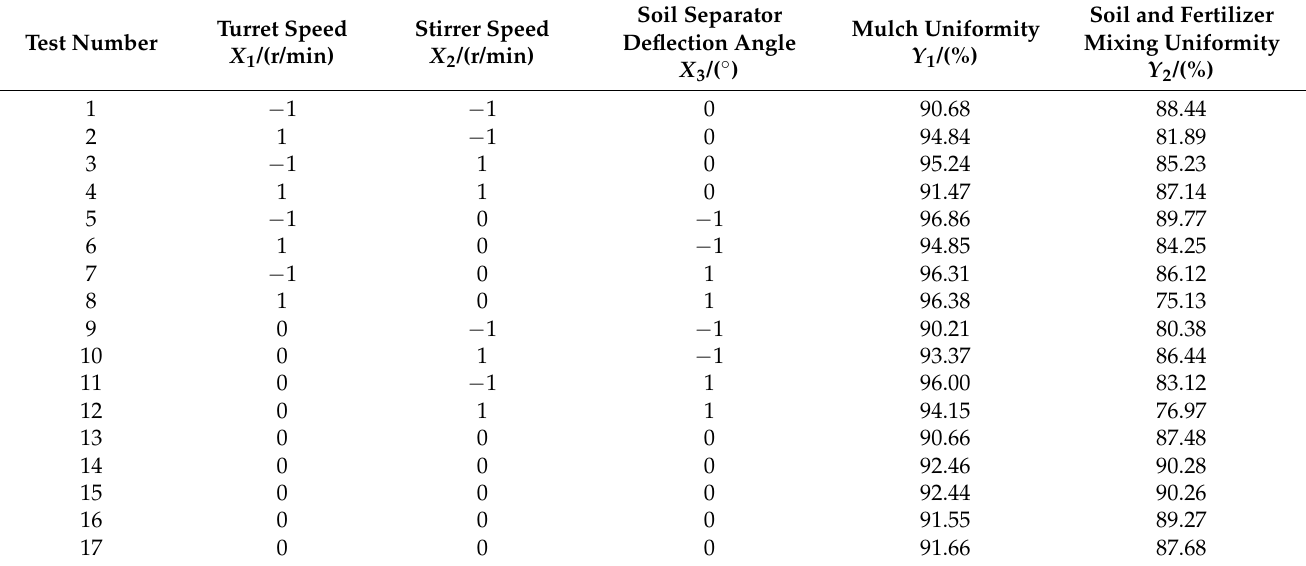
Table 4. Response surface test scheme and results.